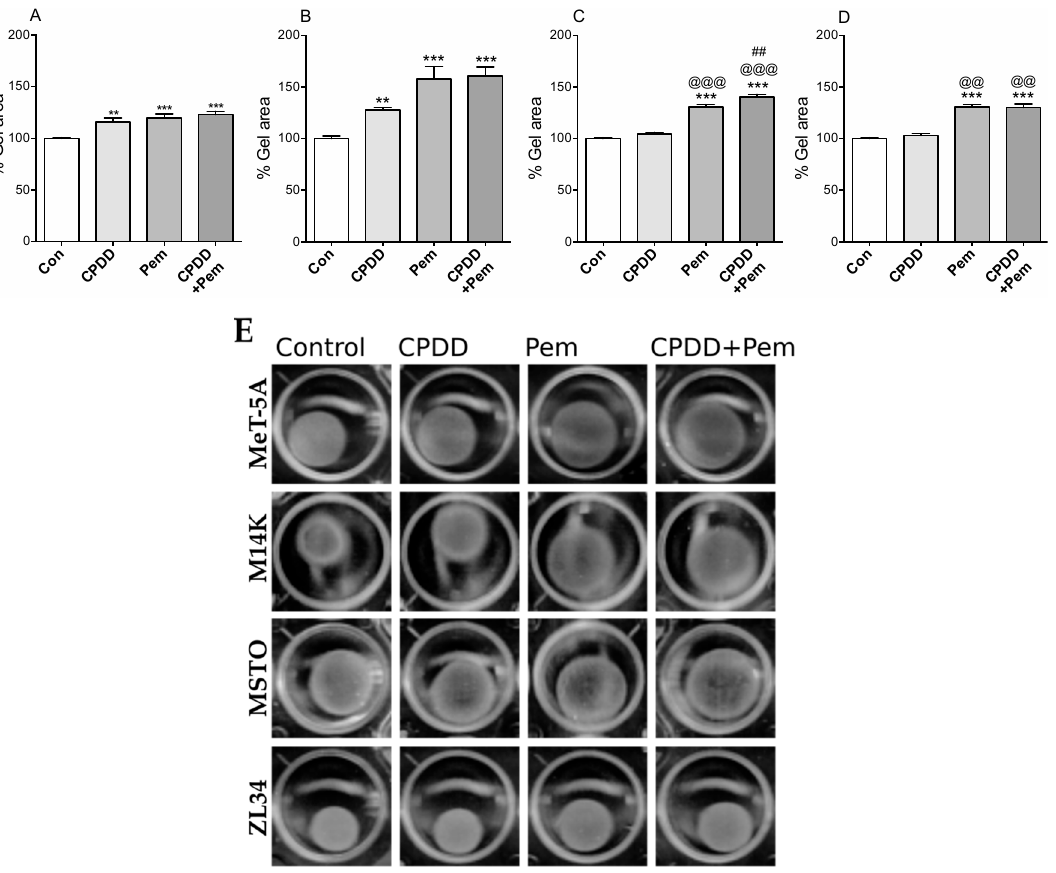
Figure 4. Mean values of gel area ± SEM without or with treatments (CPDD, Pem, or CPDD+Pem) expressed as % of Controls (cells with 10% FBS-RPMI) along with representative microscopy images from each group. ( A ) MeT-5A cells ( n = 12), ( B ) M14K cells ( n = 12), ( C ) MSTO cells ( n = 16), ( D ) ZL34 ( n = 11–12). ** p < 0.01 and *** p < 0.001 vs. Controls, @@ p < 0.01 and @@@ p < 0.001 vs. CPPD, ## p < 0.01 vs. Pem. ( E ) Images of contracted gels with cell types arranged by rows and their corresponding treatments in a column wise manner.